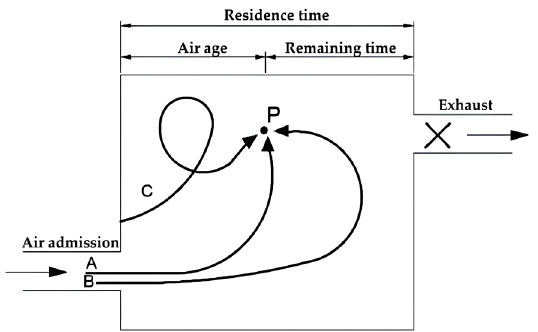
4 of 12 Figure 3. The grid model of the experimental kitchen: ( a ) Partial surface grid in the kitchen; ( b ) Body grid of the air domain in the kitchen. 2.3. Mathematical Models 2.3.1. Flow Control Equations Continuous equation: